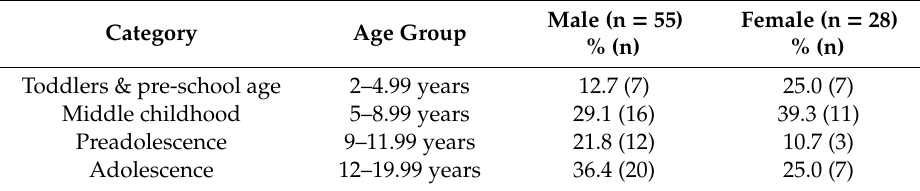
Table 1. Distribution of participants according to age and sex (n =